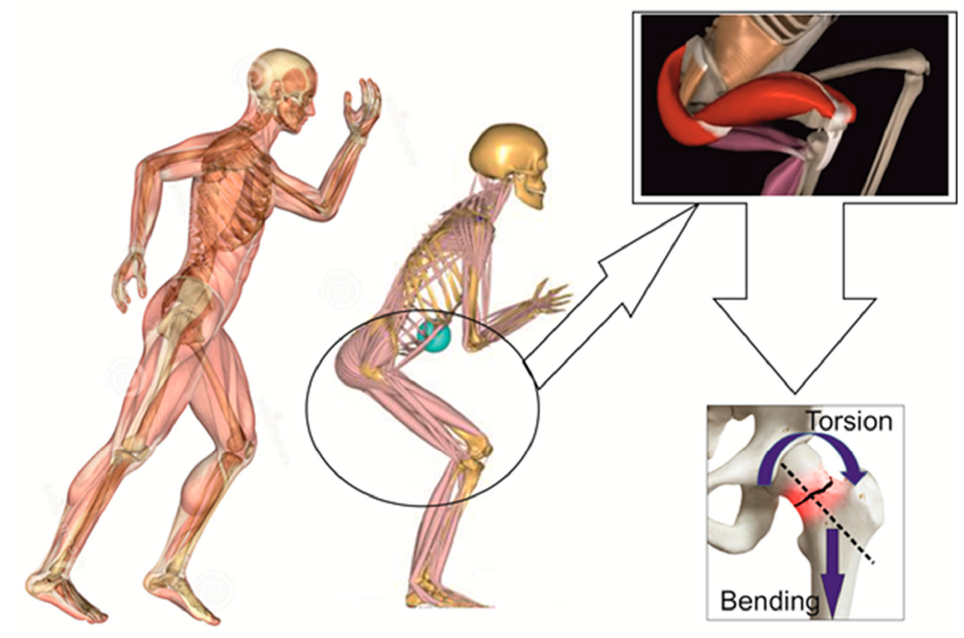
Figure 3. Simulation of the fall that led to the fracture in Case 1.